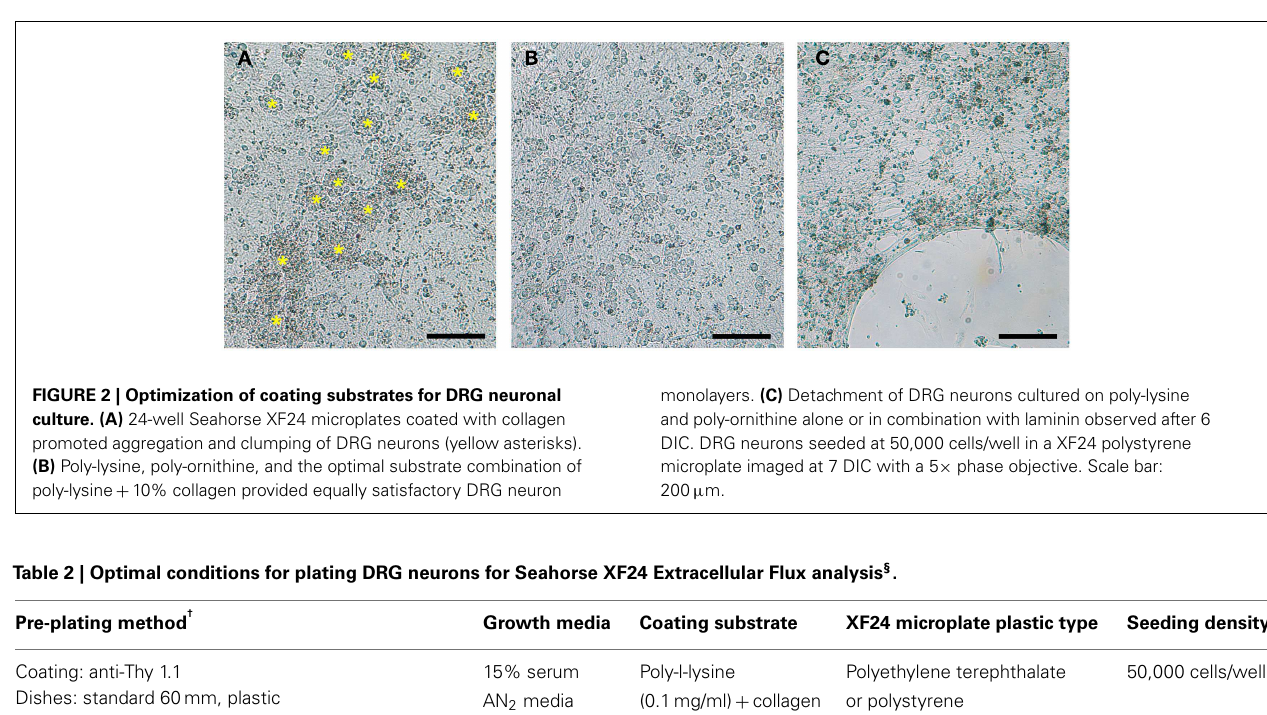
Table 2 | Optimal conditions for plating DRG neurons for Seahorse XF24 Extracellular Flux analysis § . Pre-plating method †